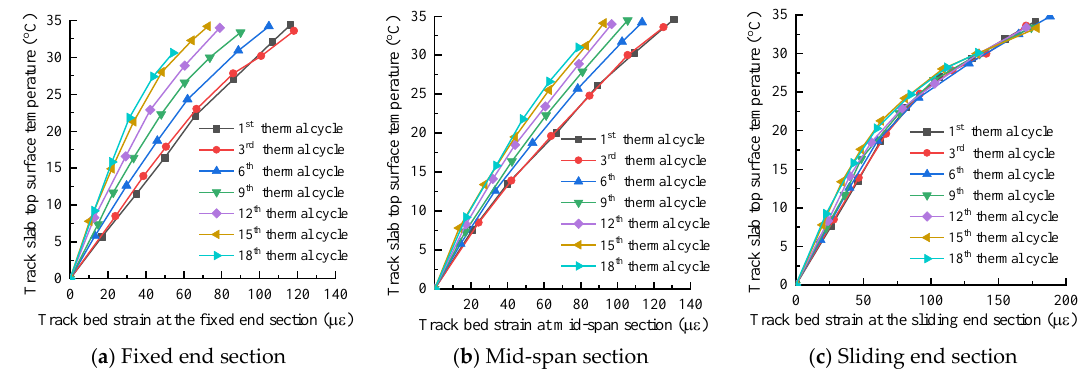
Figure 15. Track bed strain variation with the thermal load.